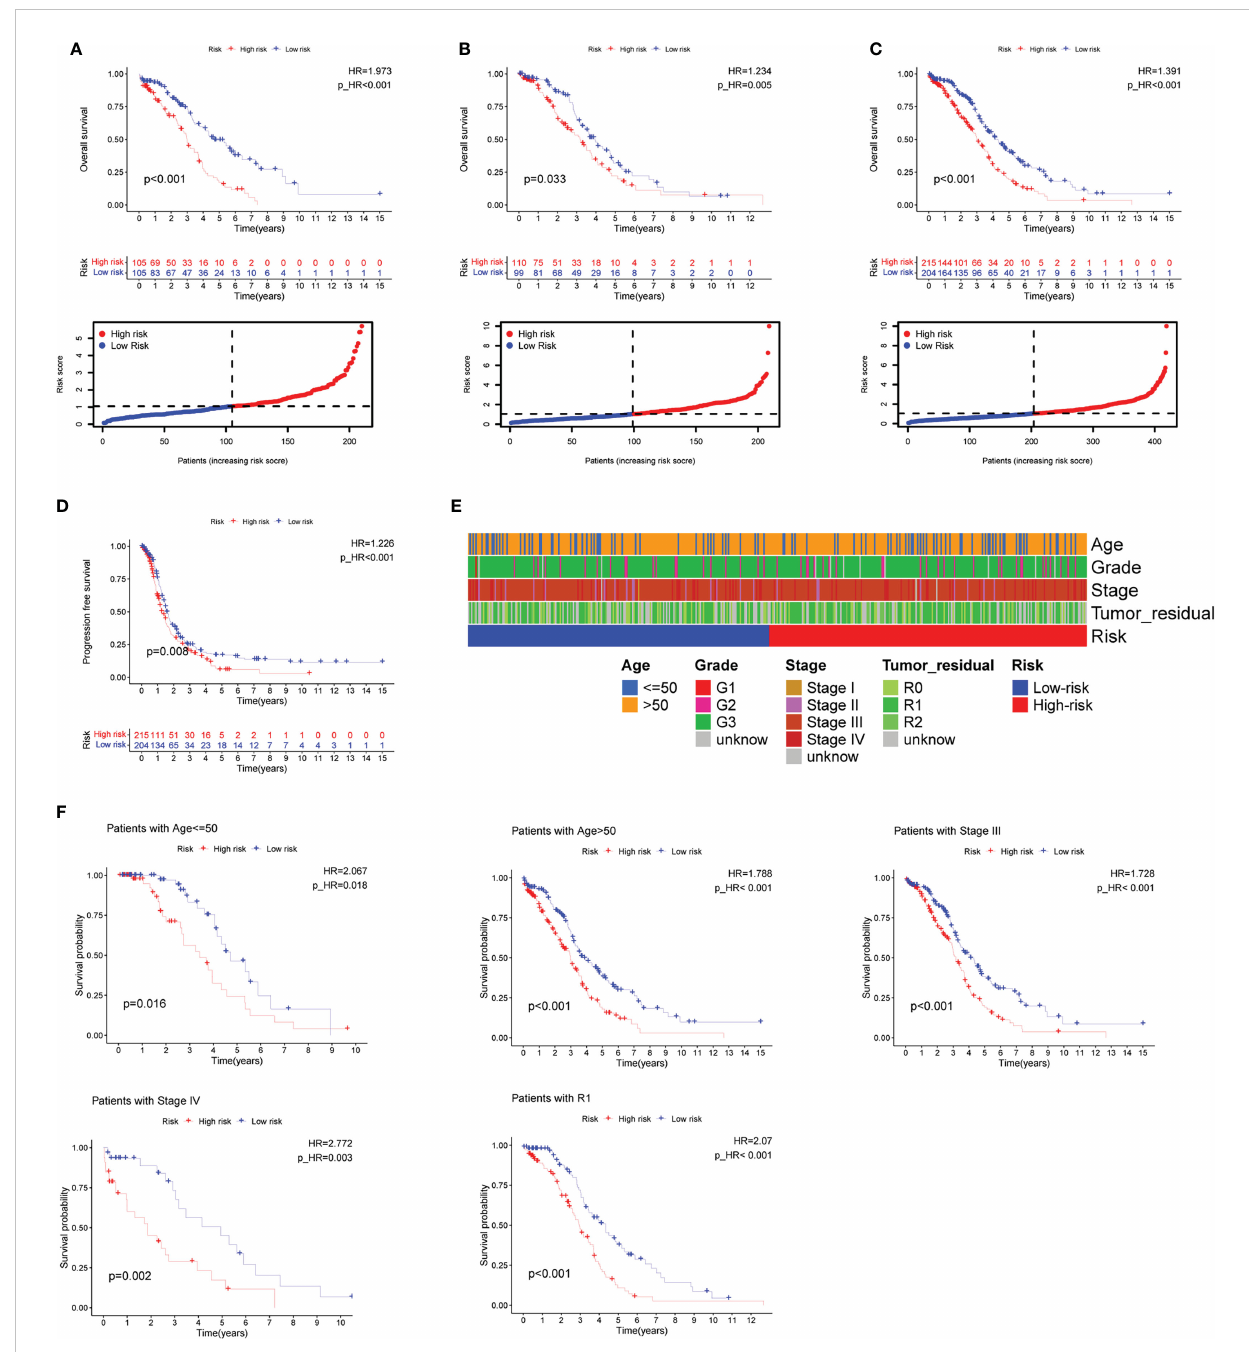
FIGURE 5 Prognosis value of the eleven CD4+ conventional T cells-related genes signature in the training, testing, and whole TCGA datasets. (A – C) Overall survival (OS) analysis in the training, testing, and whole TCGA datasets. (D) Progress-free survival (PFS) in the whole TCGA dataset. (E) Clinical information comparison between the high-risk and low-risk groups. (F) The prognostic value was strati fi ed by the age, stage, and tumor residual size between high-risk and low-risk subgroups in the whole TCGA